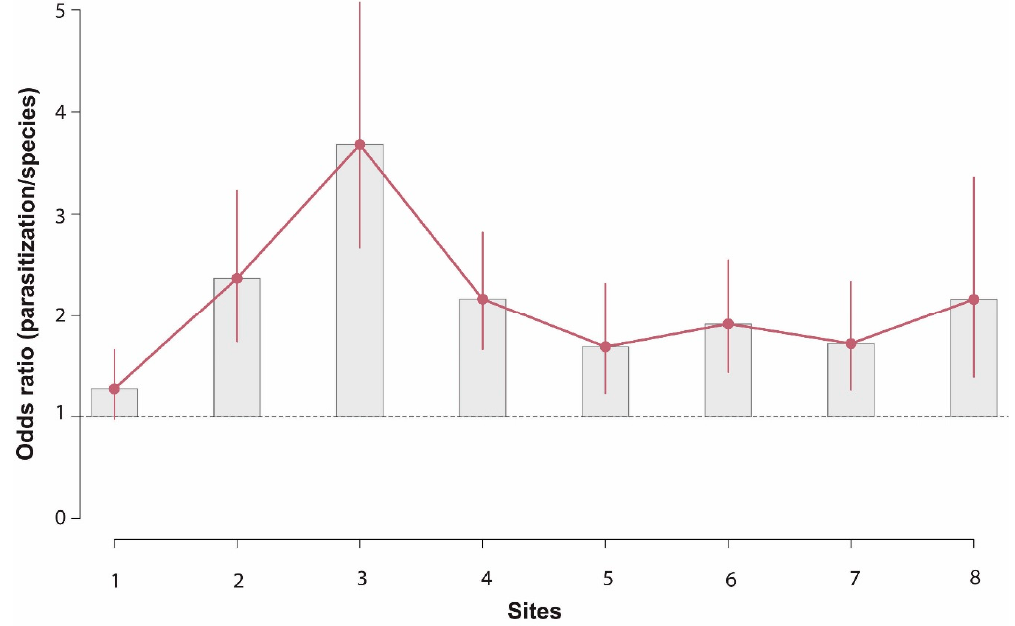
Figure 5. Odds ratios for parasitization and sites. Data are presented with 95% confidence intervals